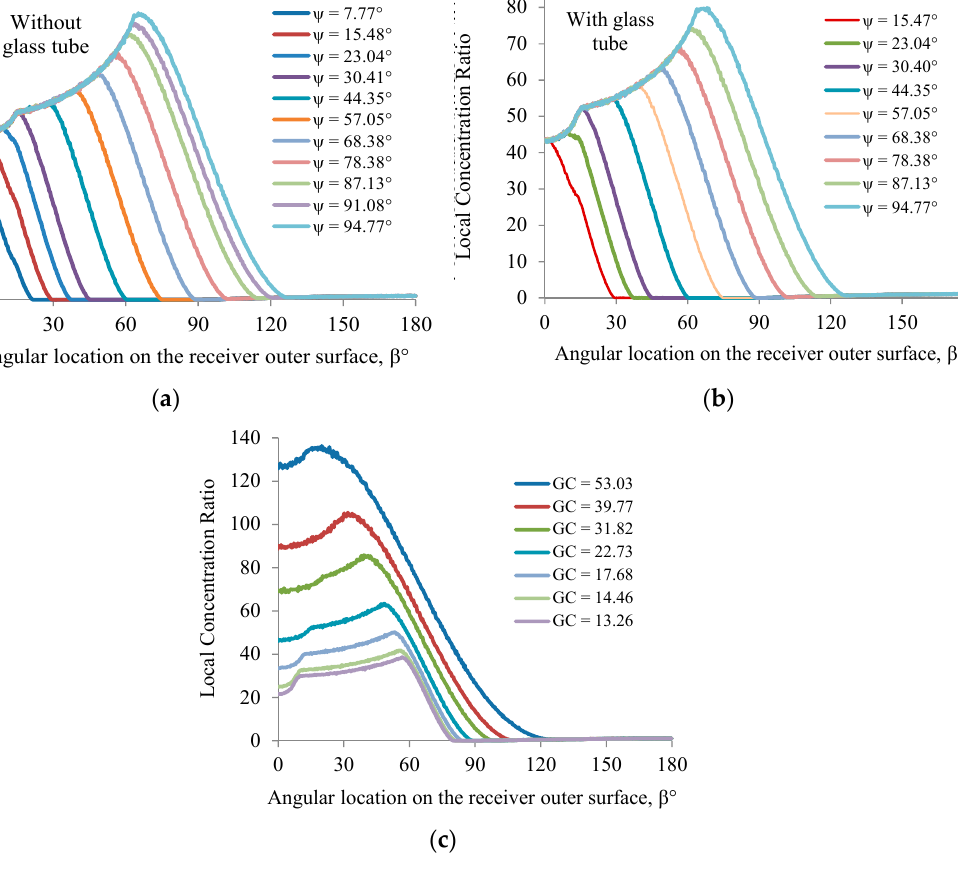
Figure 7. Effect of rim angle for, ( a ) the receiver without glass envelop and ( b ) the receiver with glass envelop, and ( c ) the effect of Geometric Concentration (GC) on LCR profile of a PTC with a mirror of fixed focal length.